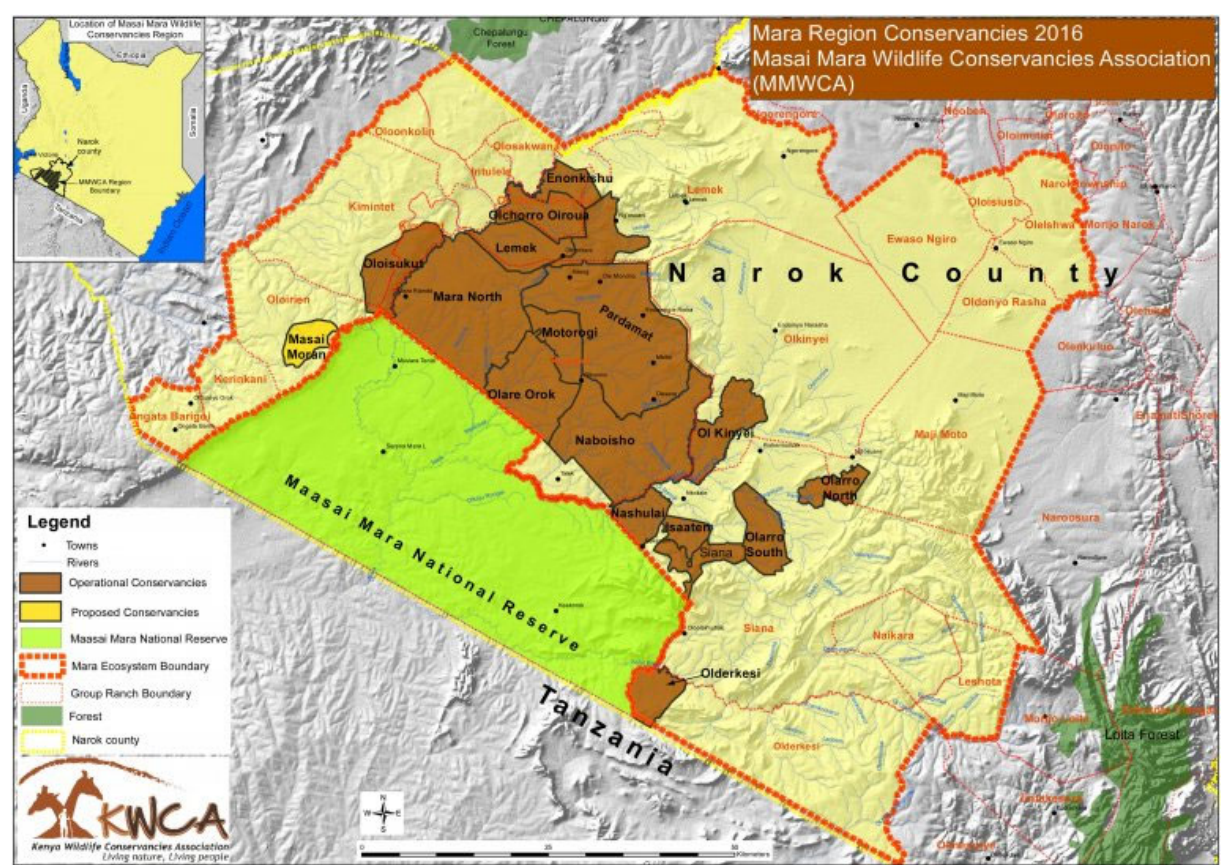
Figure 1. Study Area.